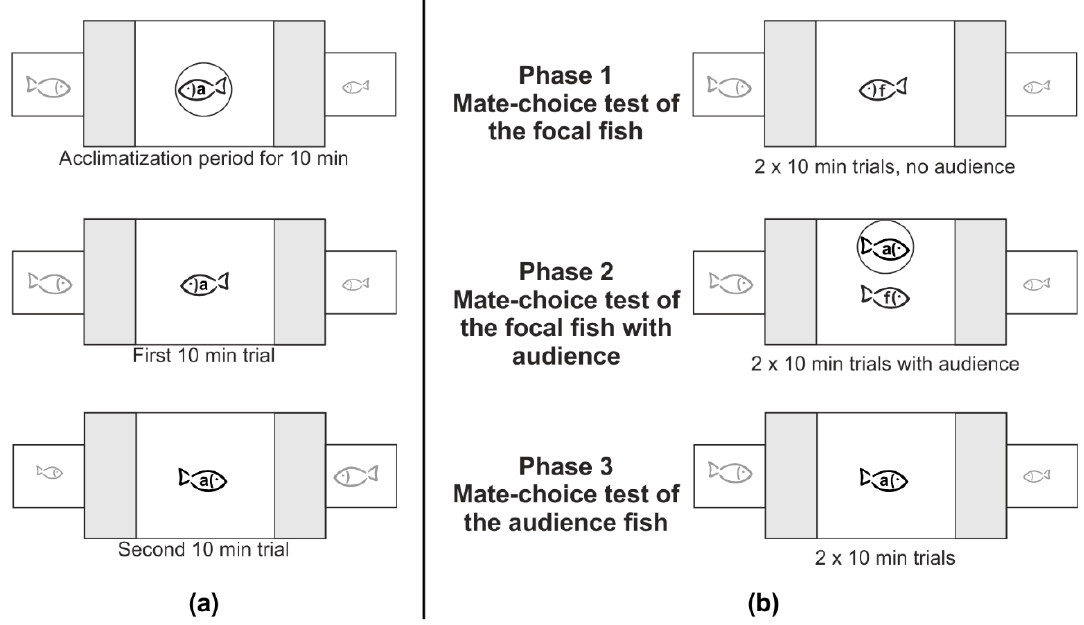
Figure 1. Setup of the ( a ) single mate-choice experiment of the audience fish on Day 1; and ( b ) setup and phases of the social mate-choice experiment of focal and audience fish on Day 2; audience fish: a, focal fish: f. Stimulus fish always differed in size by about 5 mm. Grey areas indicate mate-choice zones. Black vertical bars on the front glass of the test tank limited the grey areas and showed the position of glass sticks laying on the gravel. Circle indicates Plexiglas cylinder.